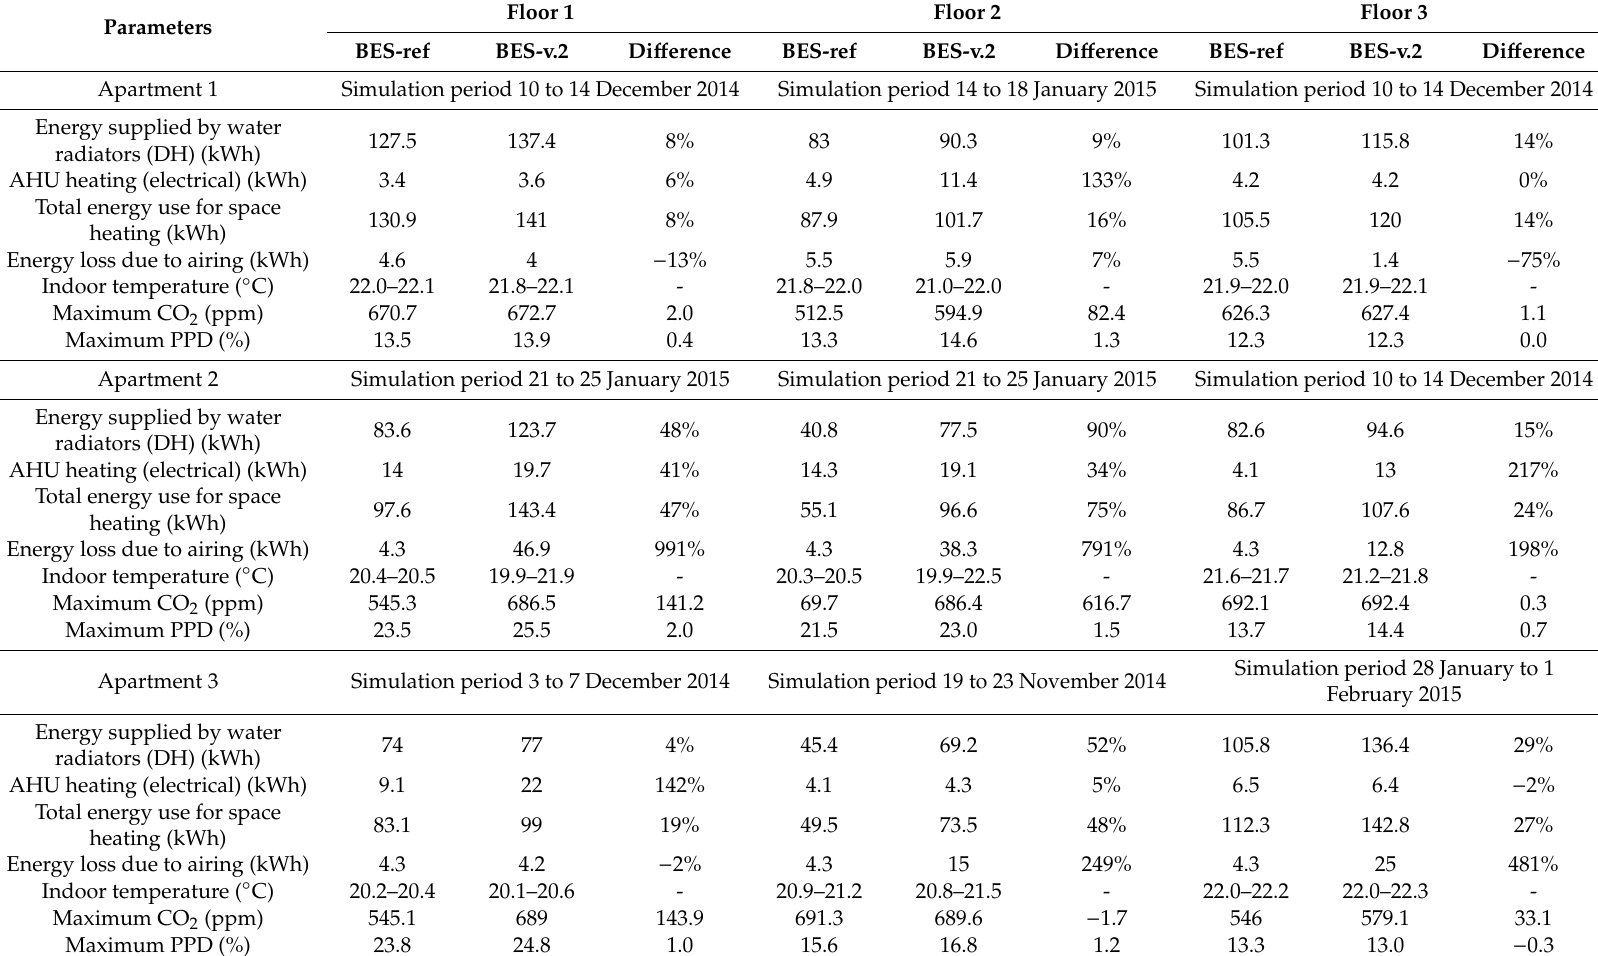
Table 11. Results at the apartment level from simulations using the two models (BES-ref and BES-v.2). The simulations were done for the same period as the logged measurements, and the time diaries were done for each